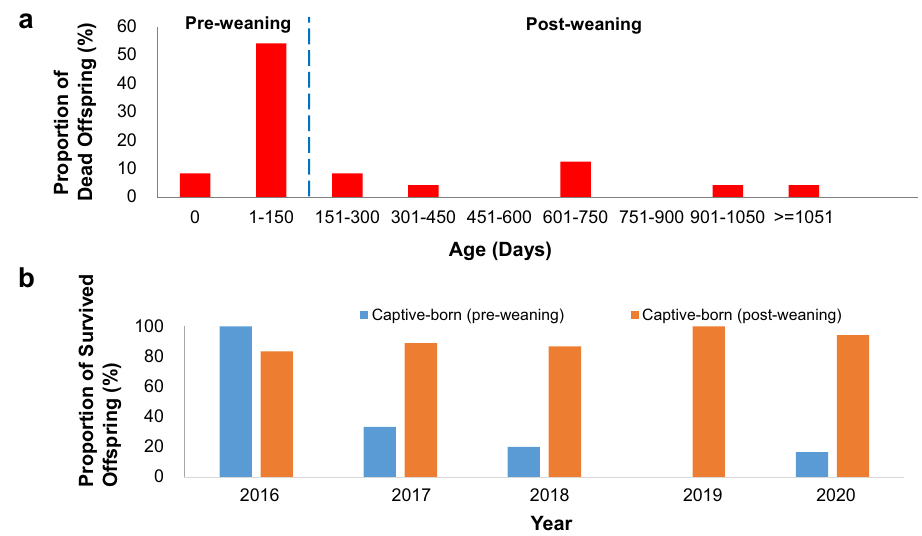
Fig. 3 Mortality of captive-born Malayan pangolins ( M. javanica ). a Mortality of captive-born offspring as a function of ages. b Comparison between the proportion of surviving offspring between pre-weaning and post-weaning offspring across different years.